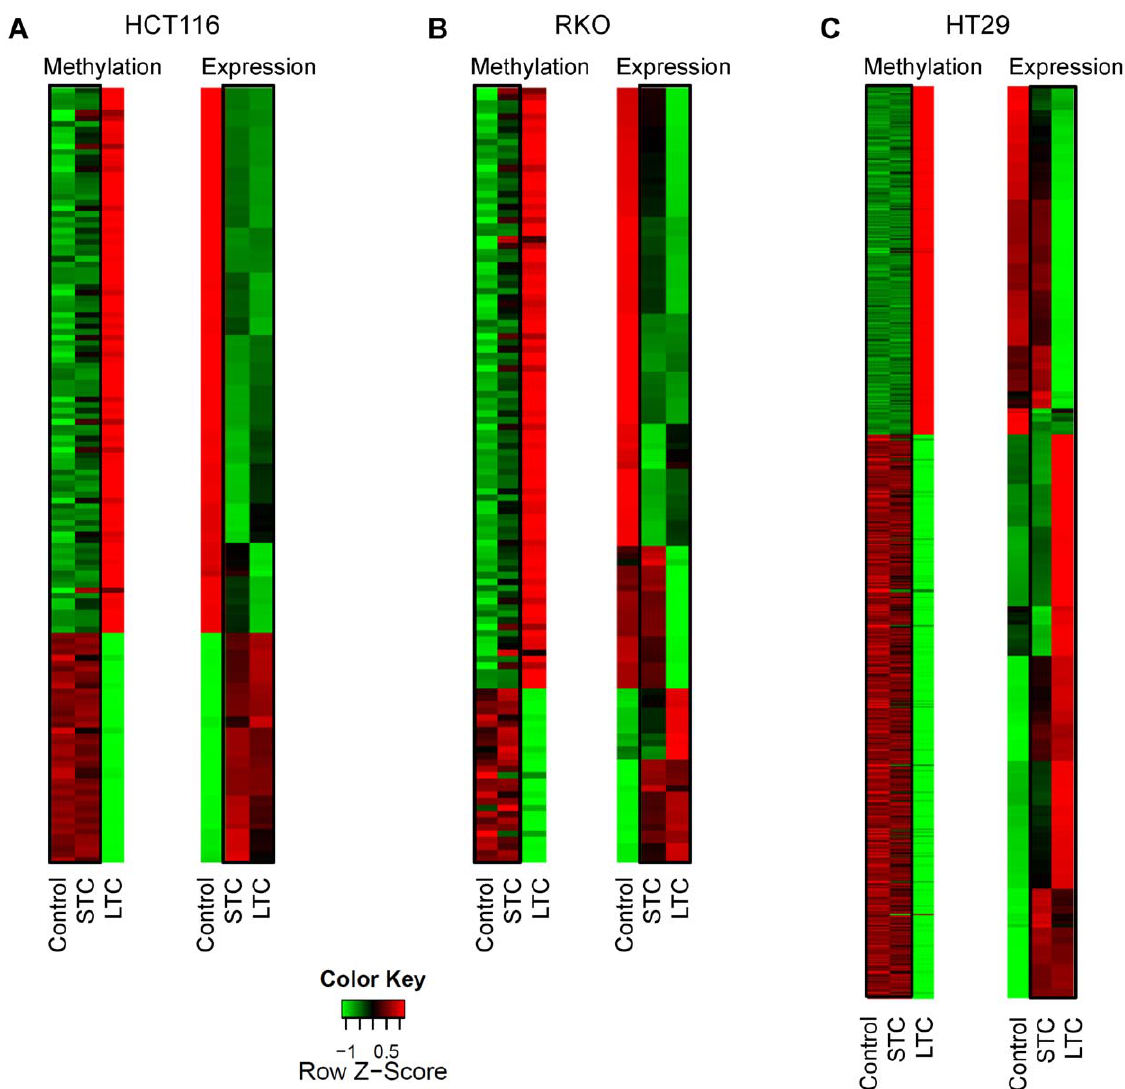
Figure 7. Comparable gene expression changes among short, and long-term curcumin-treated cells. Heatmaps displaying genes with the most discordant expression when comparing gene expression and methylation profiles with HCT116, HT29 and RKO control and treated samples. Genes were selected based on the significance of the inverse correlation between methylation and gene expression as shown in Figure 6. Rows represent genes, and columns represent samples; the intensity of each color denotes the standardized ratio between each value and the average methylation/expression of each gene across all samples. Red pixels correspond to an increased abundance of the transcript in the indicated samples, whereas green pixels indicate decreased transcript